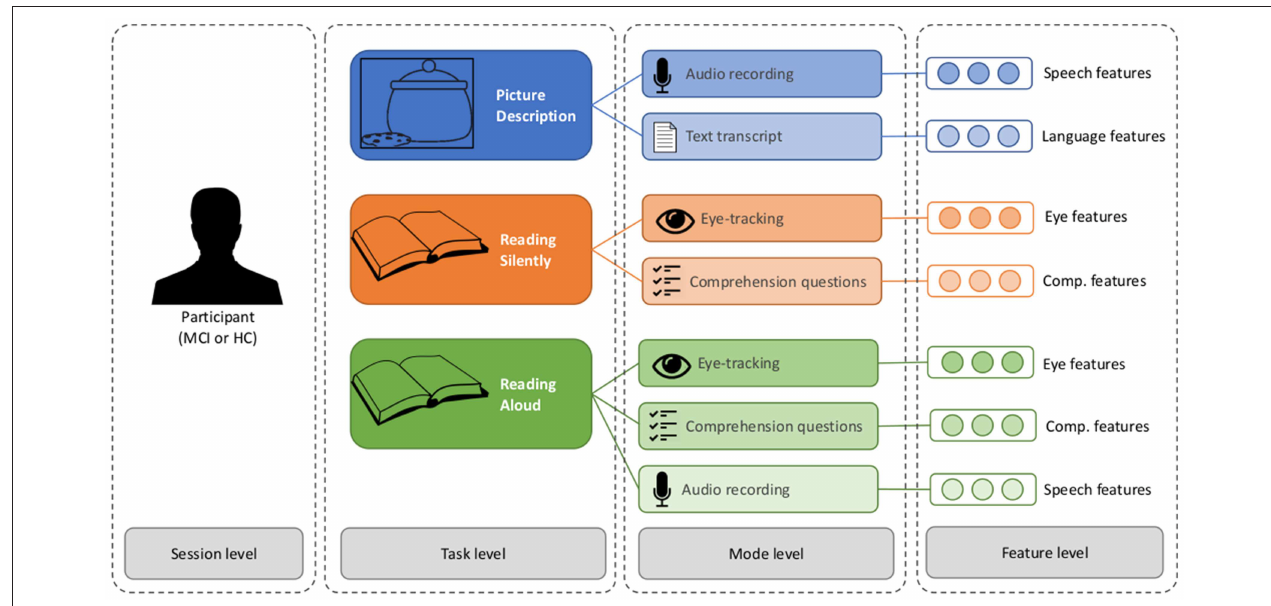
FIGURE 1 | The different levels of analysis in the multimodal dataset.